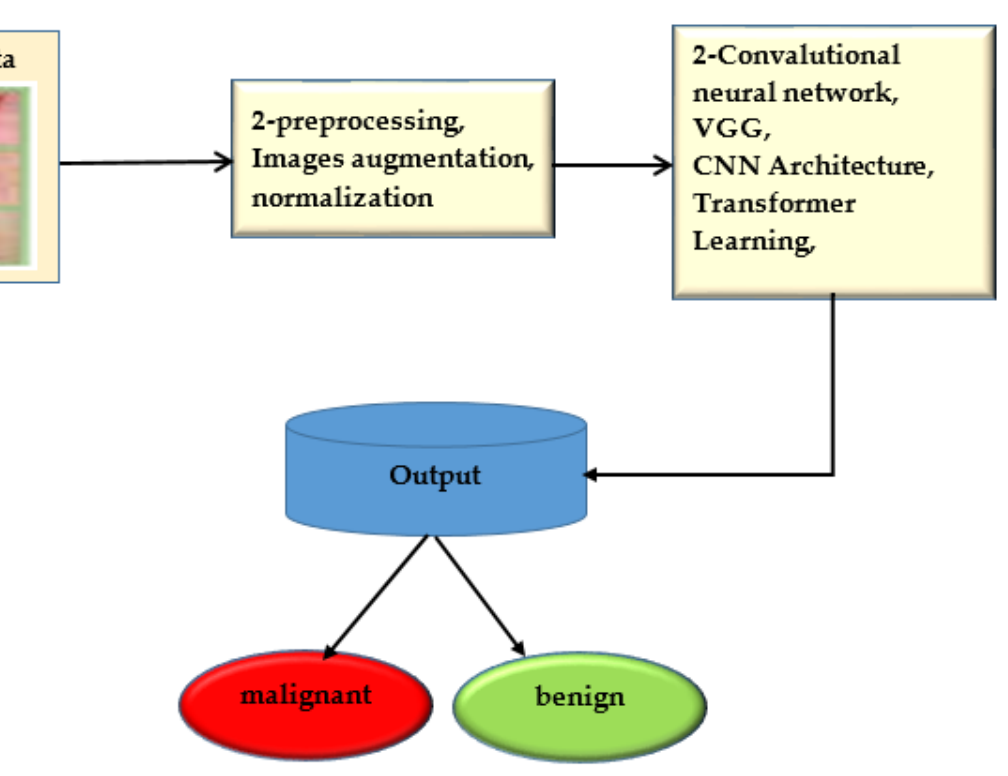
Figure 6. Convolutional neural network.